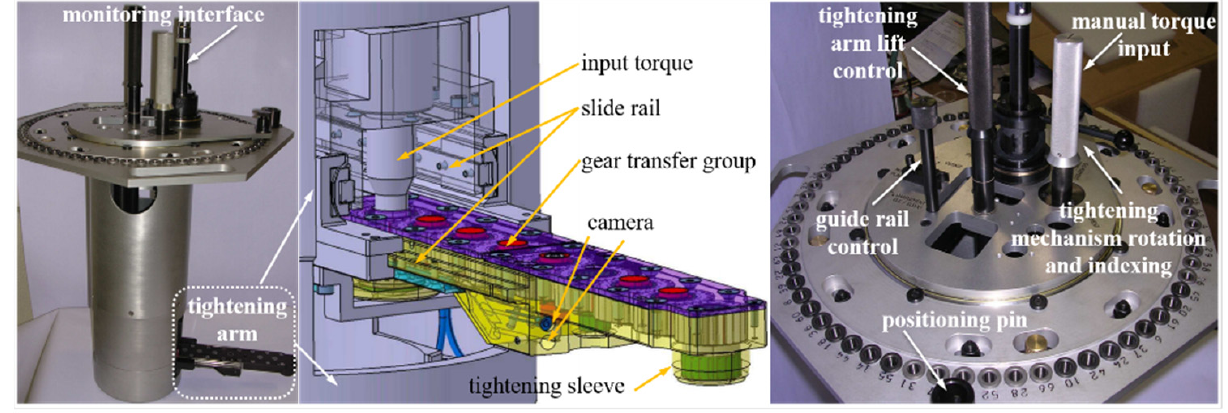
Figure 21. Marposs visual manual tightening equipment [92].